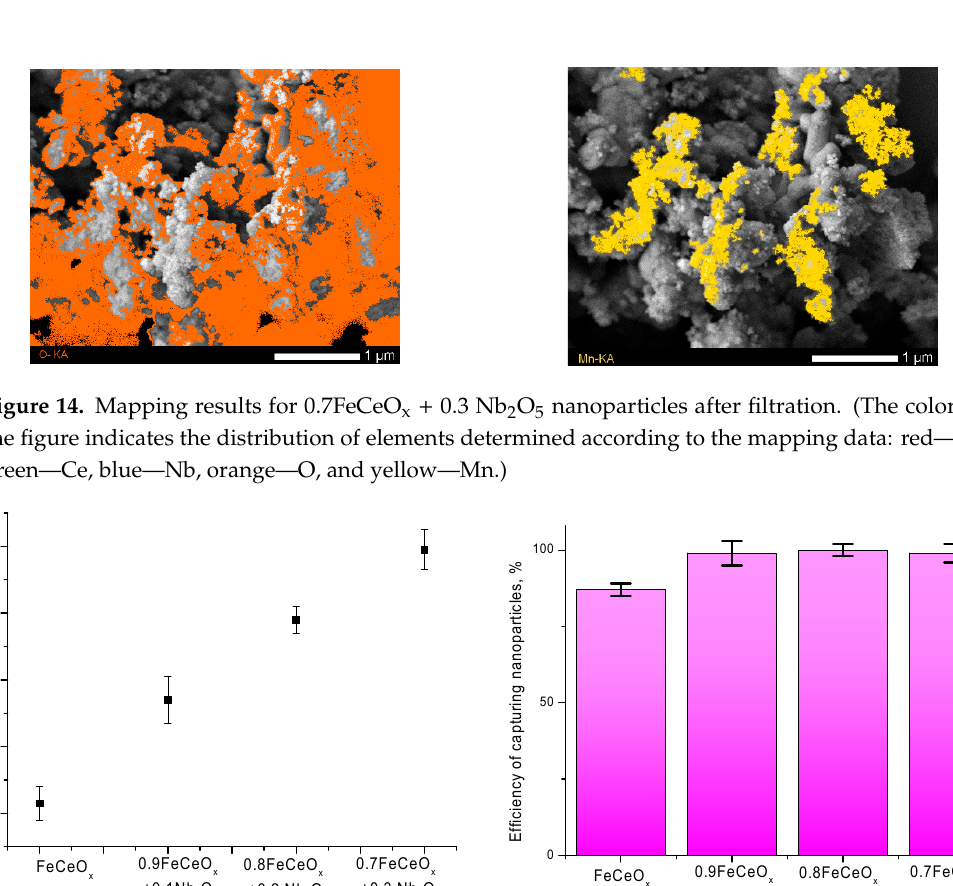
Figure 15. Data of energy dispersion analysis and conservation of mass of nanoparticle samples after filtration: ( a ) graph of changes in the concentration of manganese on the surface of nanoparticles after filtration; ( b ) graph of the efficiency of capturing nanoparticles after filtration.